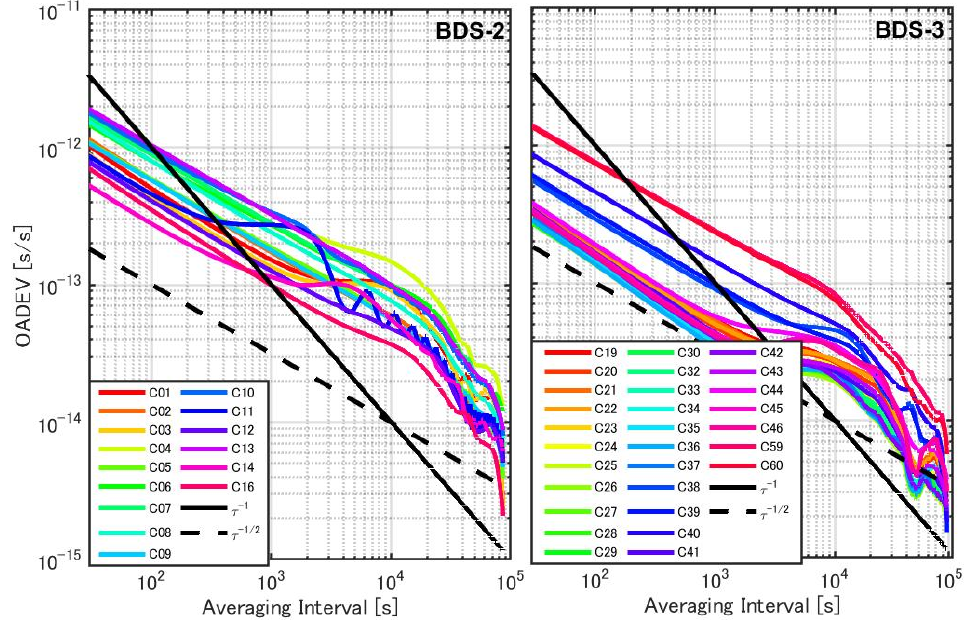
Figure 11. OADEV comparison of BDS-3 and BDS-2 clock offsets.